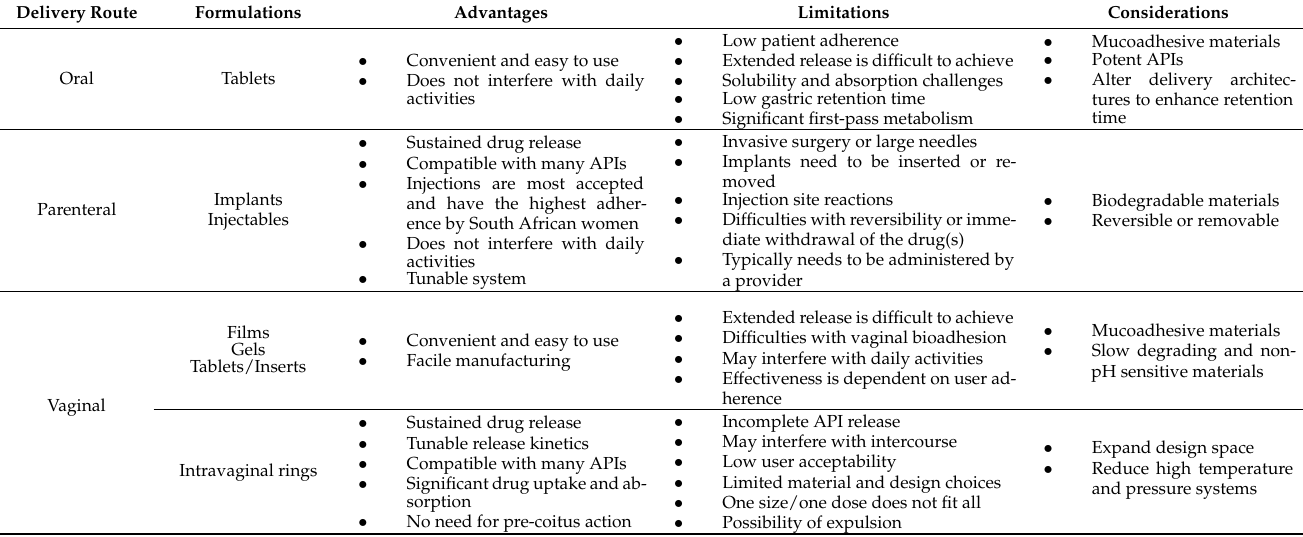
Table 2. Comparison of MPT delivery routes and